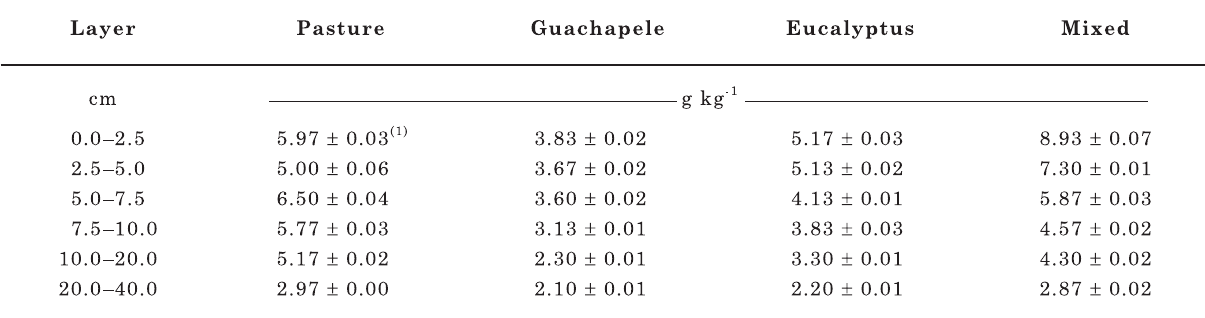
Table 2. Total carbon concentration ± standard error for each soil layer and